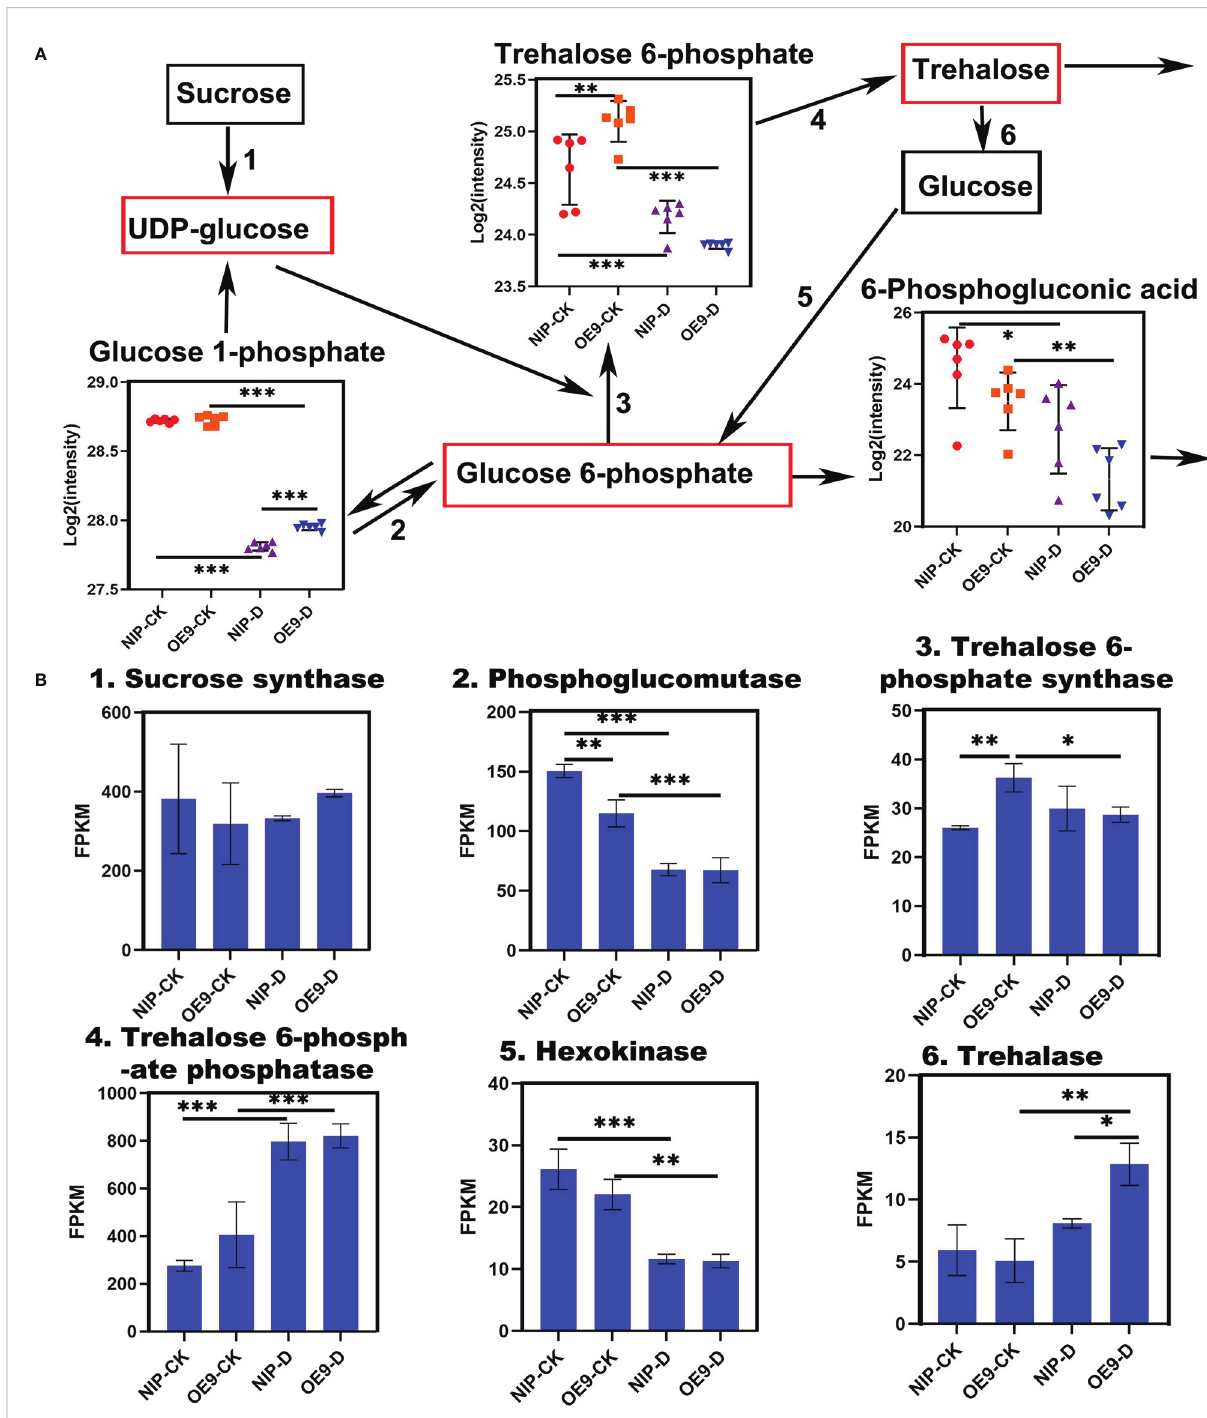
FIGURE 5 Metabolites and enzymes related to trehalose metabolism. (A) Contents of metabolites in the trehalose pathway. Black boxes indicate the substances detected by the metabolomic analysis, and red boxes indicate the substances not detected by the metabolomic analysis. (B) Expression of enzymes involved in trehalose pathway detected in the transcriptome. Data are presented as mean ± SD of six independent experiments, and signi fi cant differences between NIP-CK and OE9-CK/NIP-D or OE9-D and OE9-CK/NIP-D plants according to one-way ANOVA are indicated by asterisks. CK: NIP or OE9 materials without drought treatment. OE9: OsCIPK17 -OE9. D: drought treatment. Asterisks indicate signi fi cance (*p < 0.05, **p < 0.01, ***p <